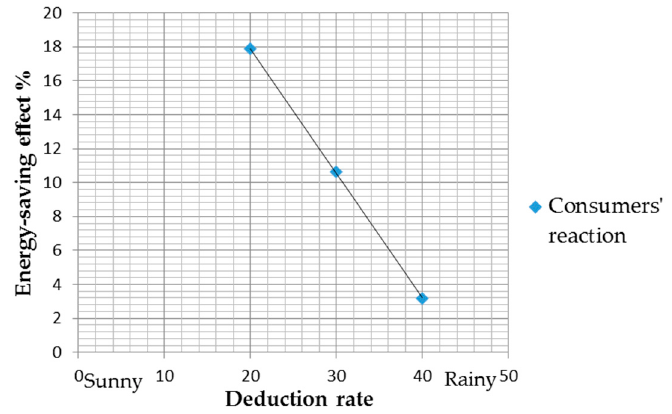
Figure 8. Consumers’ reaction to marginal changes of deduction rate.